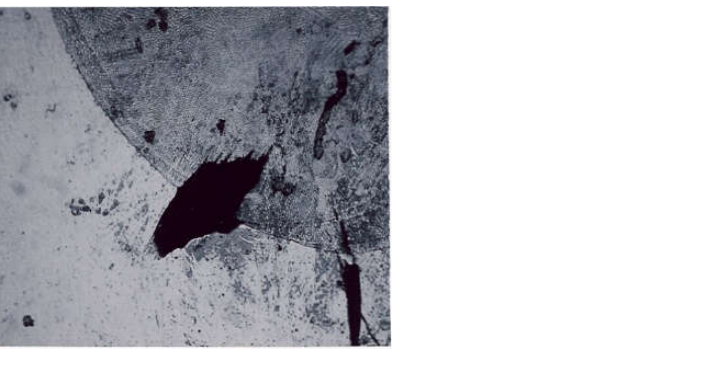
Figure 20. Comparative presentation of the average scanning curves of the weld in the longitudinal (L) and transverse (T) directions of the assembly. Sample #8.